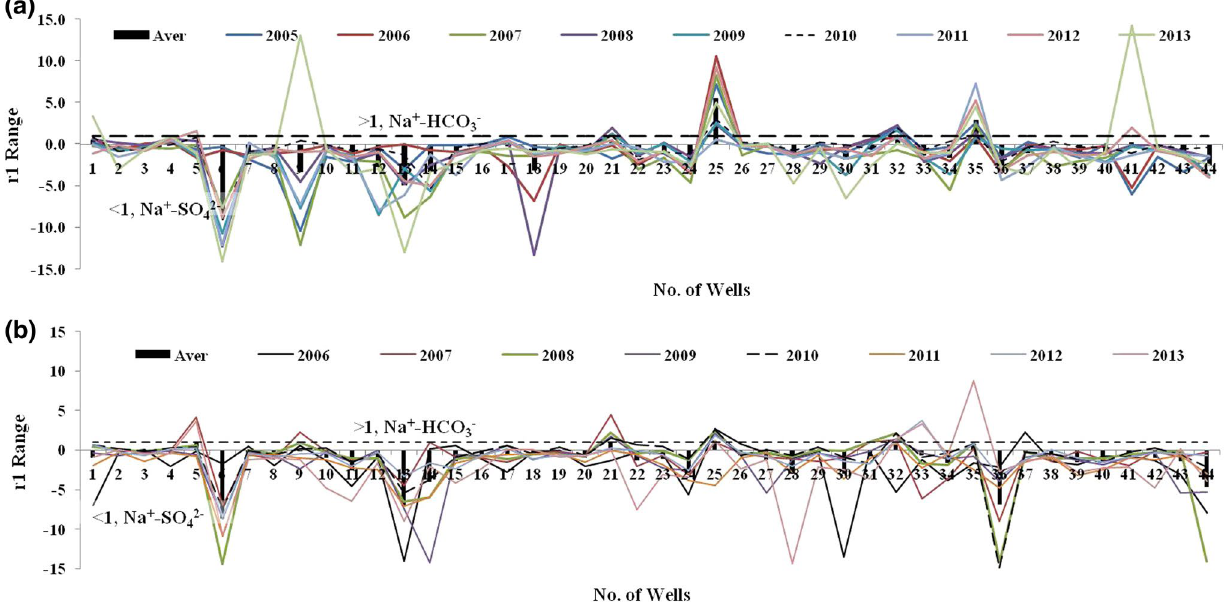
1 value during pre-monsoon. b Nine-year (2006–2013) temporal representation of